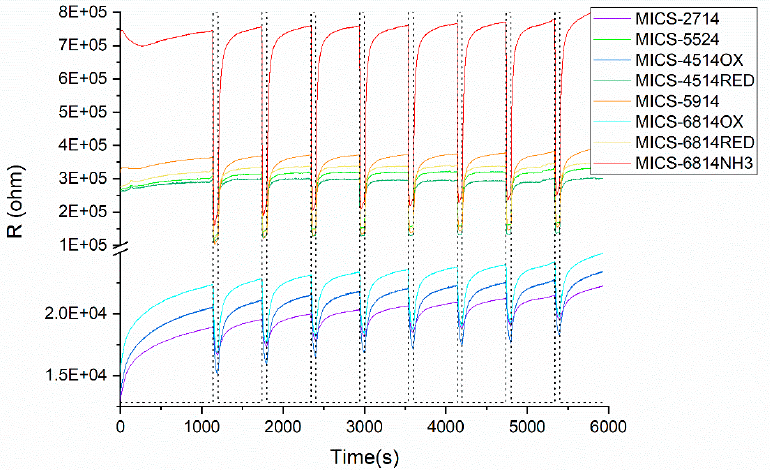
Figure 2. Resistance variations of sensors exposed to blank cork samples. Dashed lines correspond to the sampling electrovalve status (ON/OFF).